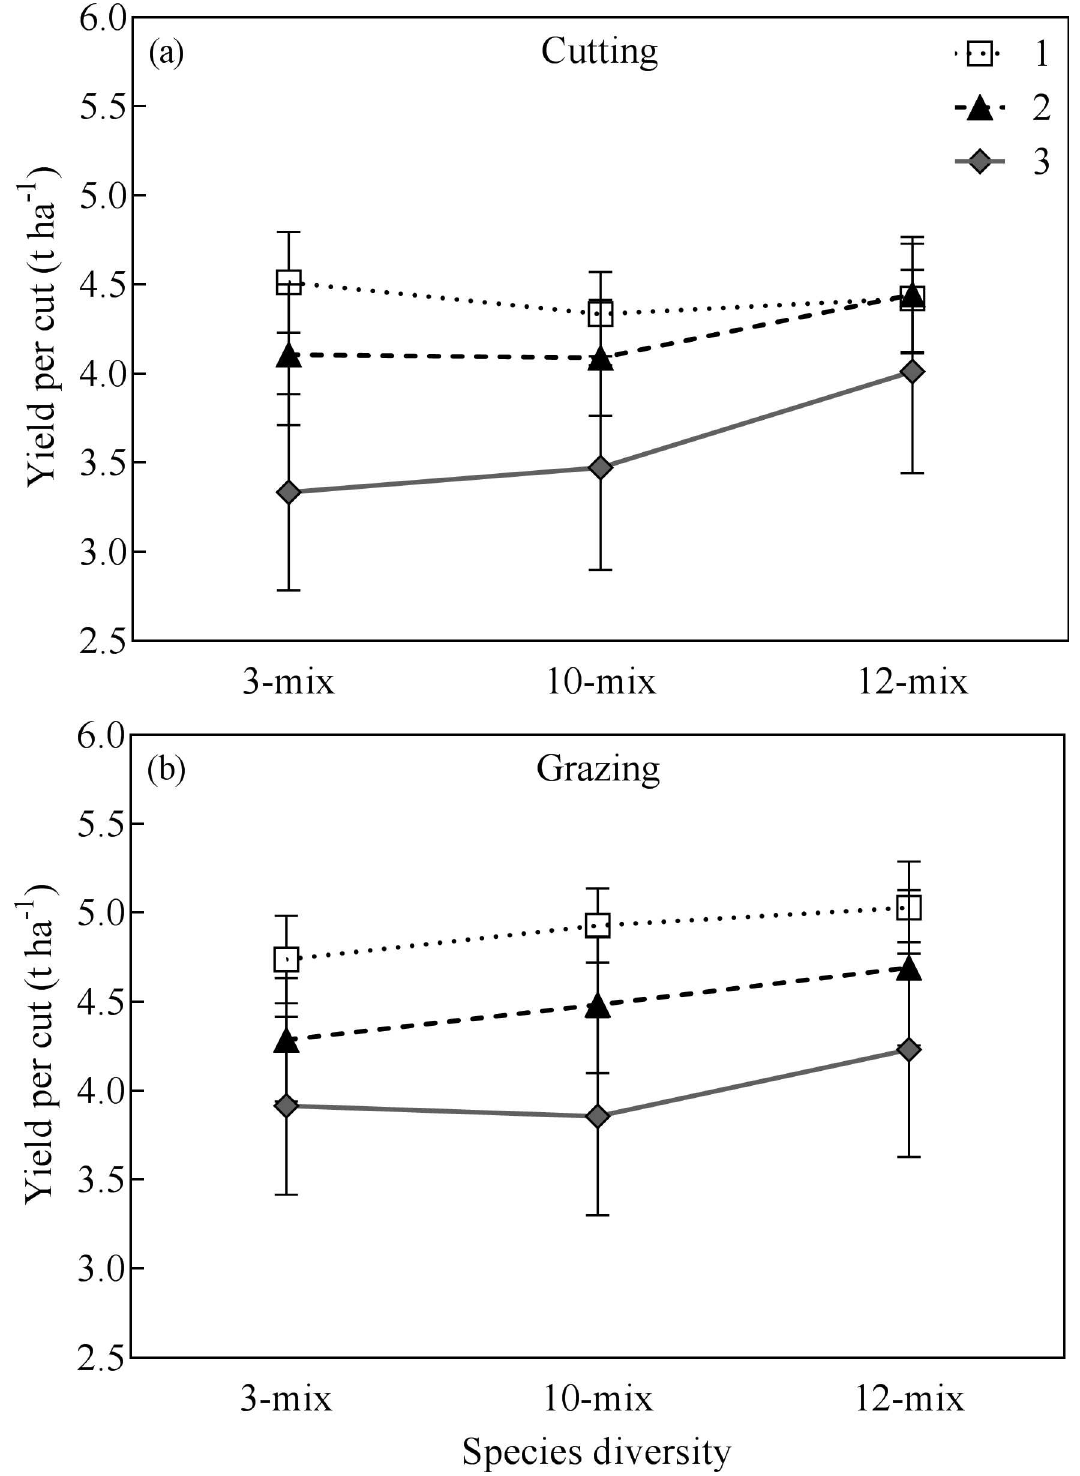
Fig 2. Yield (mean ± SE) per cut of mixtures with increasing species diversity under cutting and grazing management of 1- to 3-yr-old grasslands.